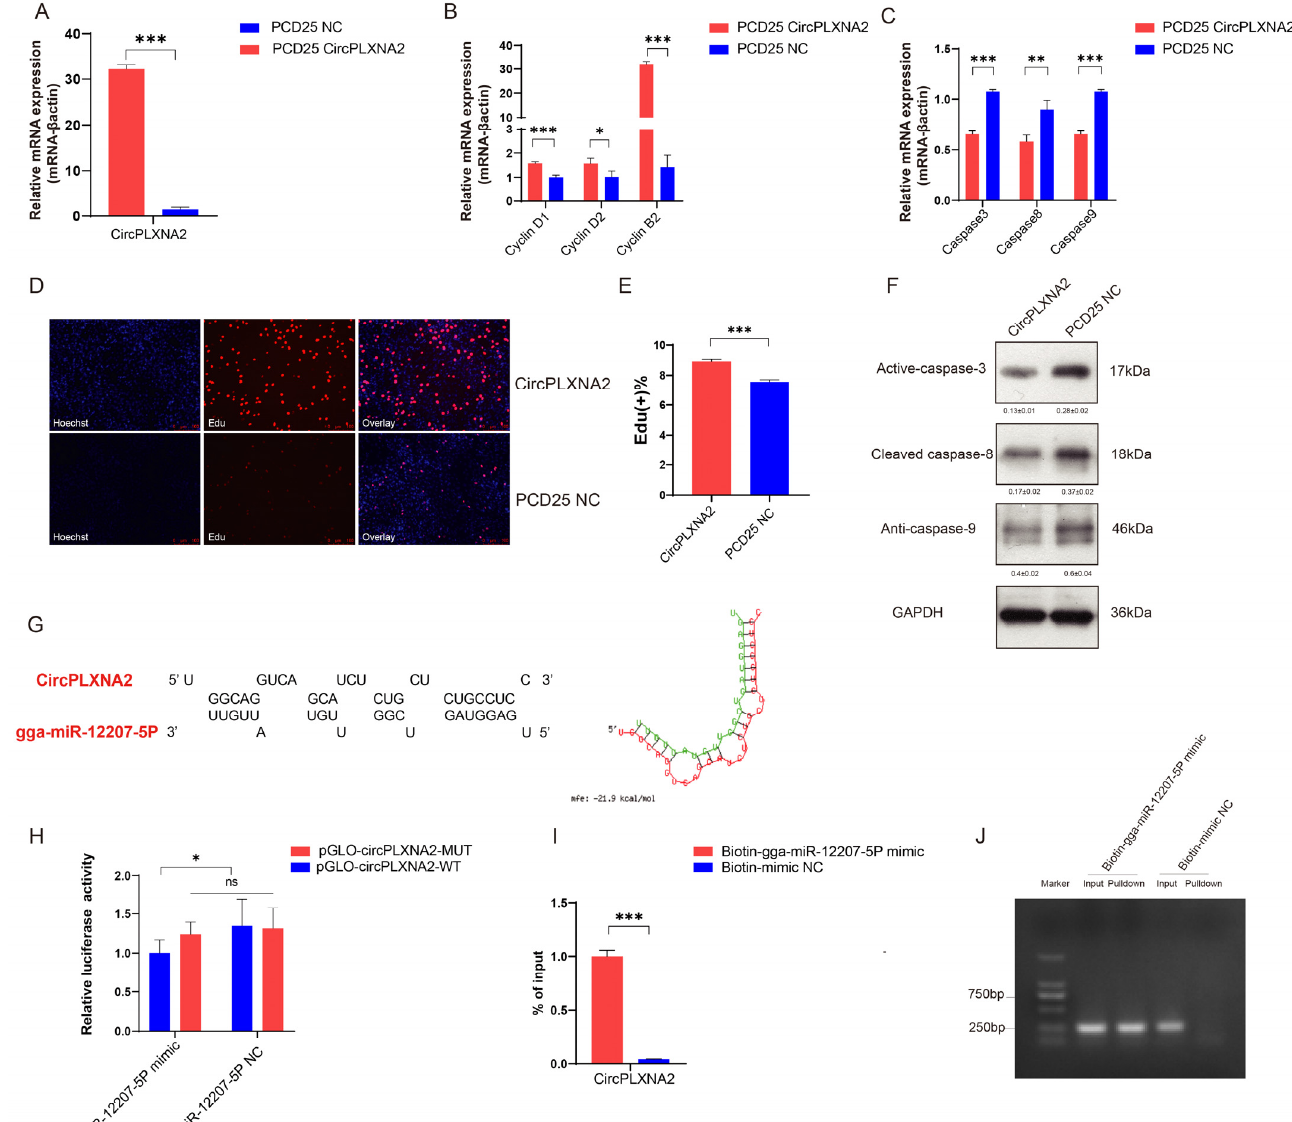
Figure 4. CircPLXNA2 promoted cell proliferation, inhibited cell apoptosis, and sponged gga-miR-12207-5P. ( A ) Efficiency of overexpression of circPLXNA2 . ( B ) qRT-PCR results of Cyclin B2, cyclin D1, cyclin D2, and cyclin B2 genes after circPLXNA2 overexpression. ( C ) qRT-PCR results of caspase 3, caspase 8, and caspase 9 genes after circPLXNA2 overexpression. ( D , E ) EdU staining ( D ) and the positive EdU cell rate (E) for myoblast cells after circPLXNA2 overexpression. ( F ) Western blotting analysis of the caspase 3, caspase 8, and caspase 9 proteins with PCD25 circPLXNA2 transfection. ( G ) Potential binding sites between circPLXNA2 and gga-miR-12207-5P predicted by the RNAhybrid online tool. ( H ) Relative luciferase activity of pmirGLO- circPLXNA2 WT/MUT plasmid with gga-miR-12207-5P mimic or gga-miR-12207-5P NC. ( I , J ) The biotin-tagged miRNA pulldown showed the interaction between circPLXNA2 and gga-miR-12207-5P (* p < 0.05; ** p < 0.01, *** p < 0.001). 2.4. gga-miR-12207-5P Inhibits Cell Proliferation and Promotes